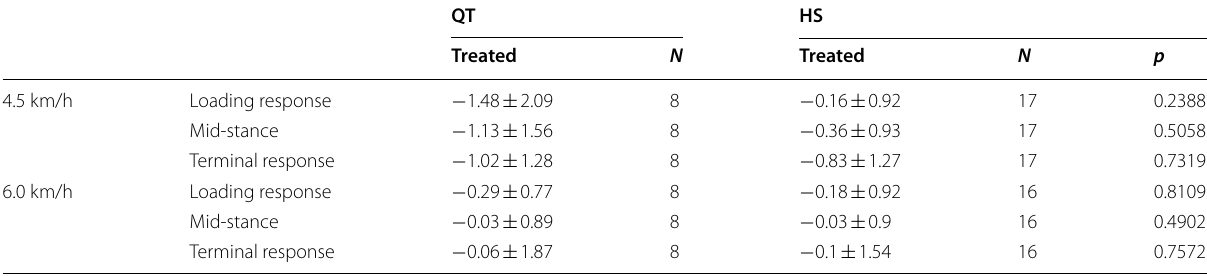
Table 2 Mean values and standard deviations of the varus–valgus angles for the treated knee in the QT and HS group during the loading response, mid-stance and terminal stance at 4.5 km/h and 6.0 km/h